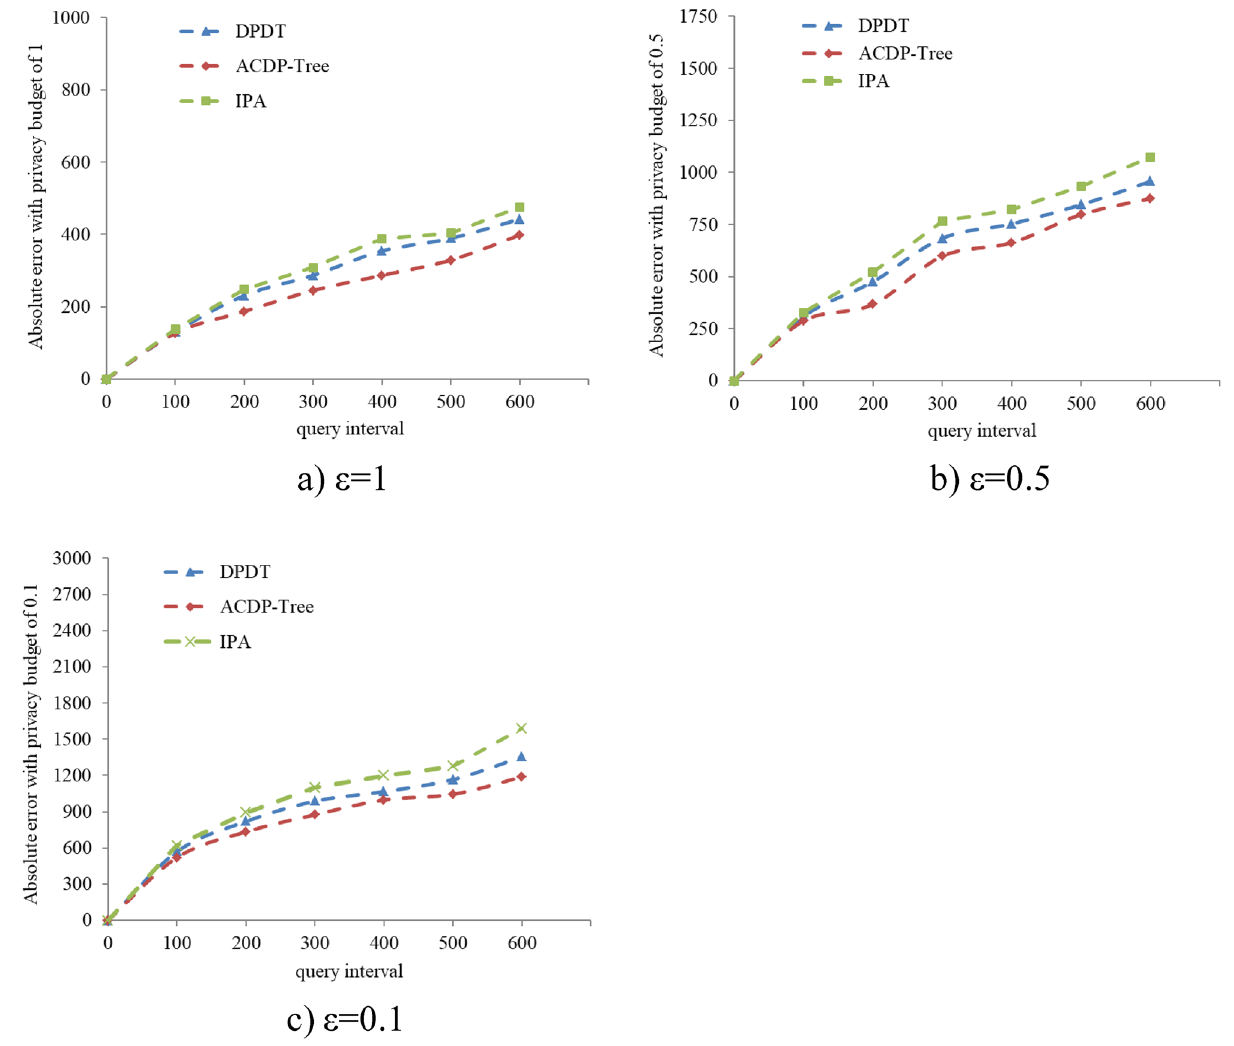
Figure 4. The change of absolute error when the query interval is 100 and ε takes different